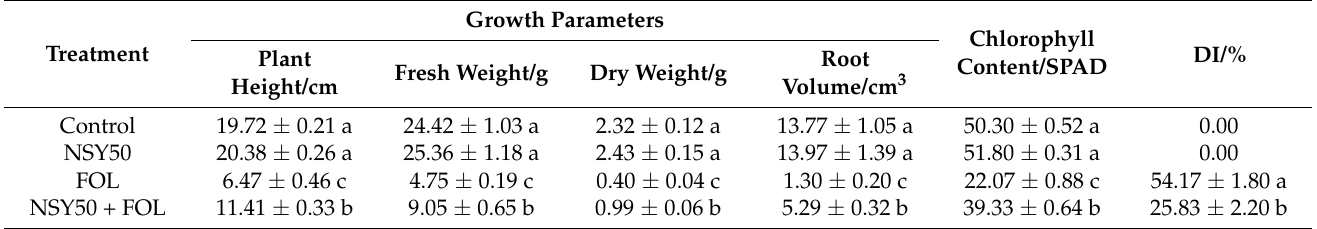
Table 1. Effects of P. polymyxa stain NSY50 on the growth, chlorophyll content and DI of tomato AC seedlings under Fol